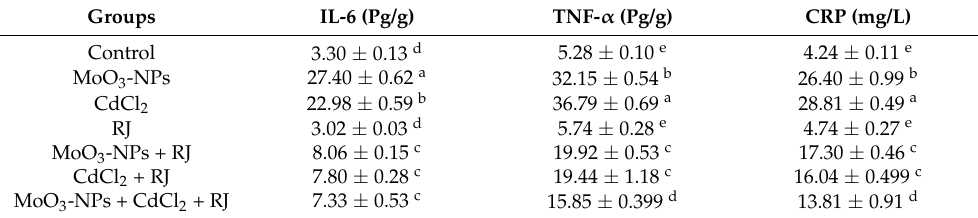
Table 3. The effects of Royal Jelly (RJ) on serum pro-inflammatory levels in male rats treated with molybdenum nanoparticles (MoO 3 -NPs), cadmium chloride (CdCl 2 ), or combinations of the two for 30 consecutive days.